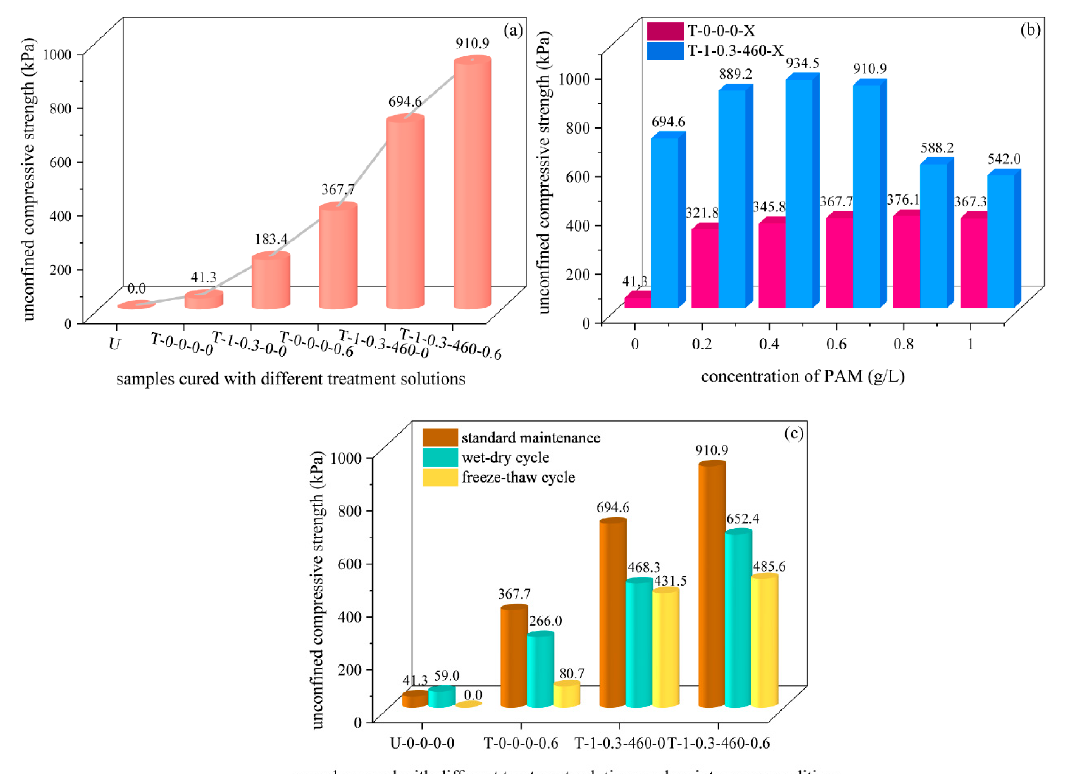
Figure 2. UCS of samples cured with different treatment solutions. ( a ) UCS of cured FA samples with different treatments (untreated (control), deionized water treatment, salt treatment, PAM treatment, EICP treatment, PAM-EICP combination treatment); ( b ) UCS of samples treated with different PAM concentrations; ( c ) UCS of samples after standard maintenance, wet-dry cycles, and freeze- thaw cycles.